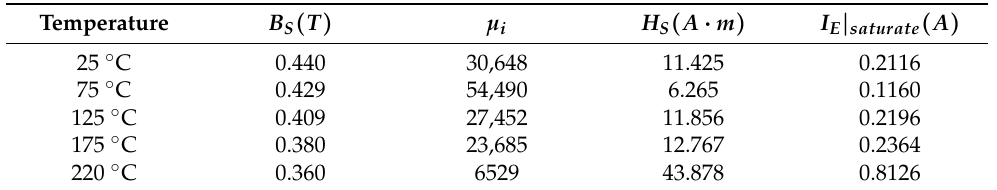
Table 1. When the core saturates at different temperatures, the approximate value of the magnetic flux density, and the corresponding field strength and excitation